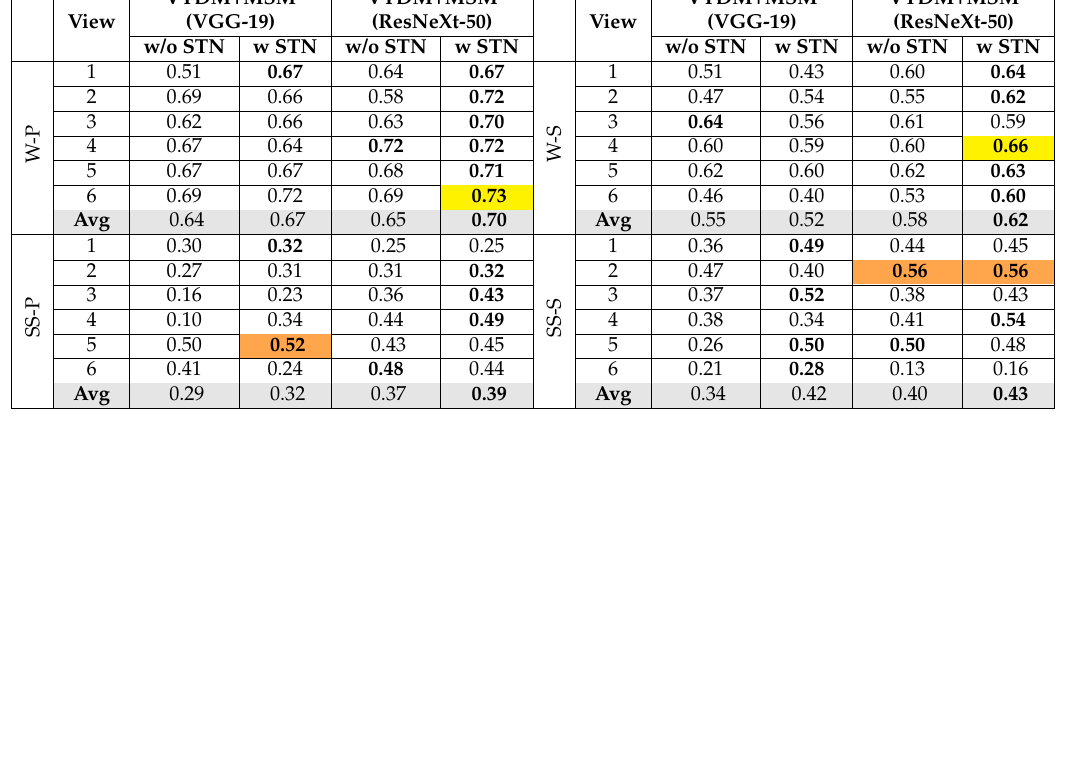
Table 5. Cross-view results for all actions with single-view training. The bold numbers show the best result for each view of each action type; Yellow highlights: best results for W-P and W-S actions amongst all views, Orange highlights: best result for SS-P and SS-S actions amongst all views. VTDM+MSM VTDM+MSM View View